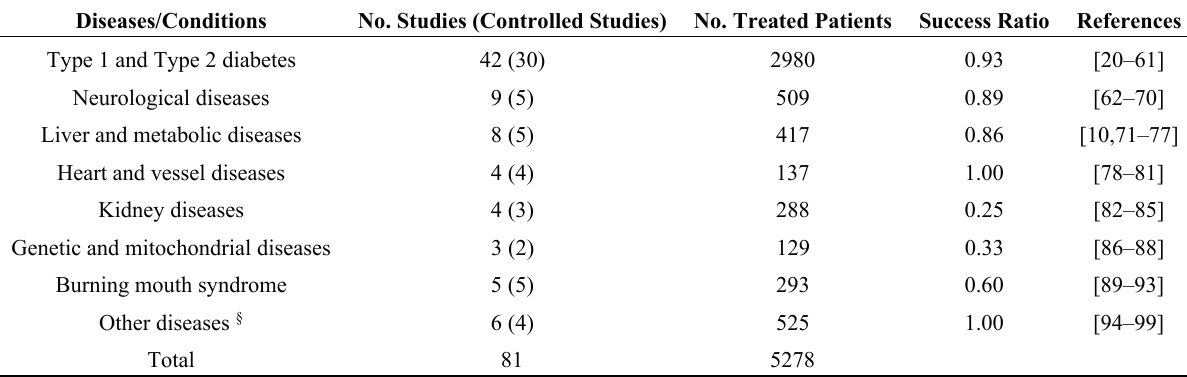
Table 1. Clinical studies utilizing α -lipoic acid aimed at compensating oxidative stress (OS)/mitochondrial dysfunction (MDF)-related pathogenetic